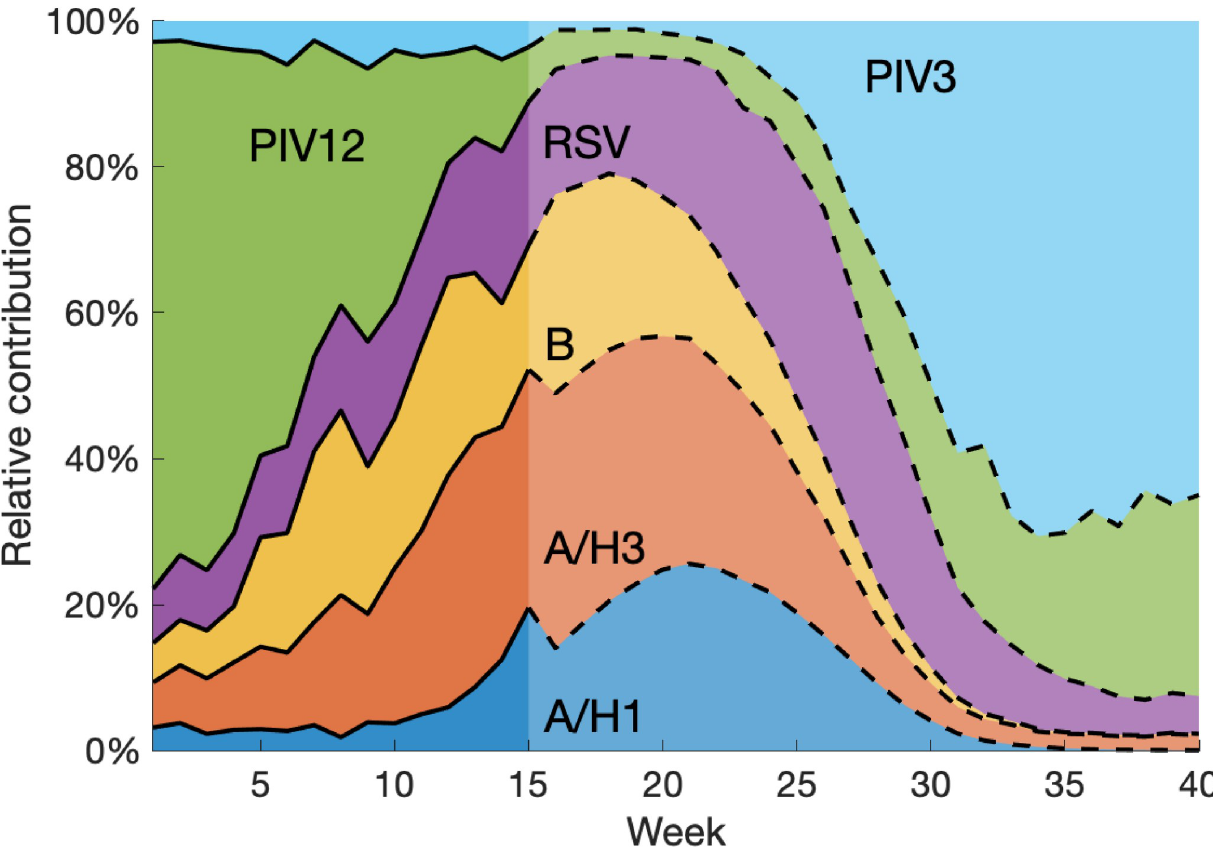
Fig 6. Forecasting the relative contribution of each pathogen to ILI. Forecasts were generated for national data at week 15 during the 2010–2011 season. The relative contribution before week 15 was inferred using available data. After week 15, it is obtained by normalizing the weighted predicted signal of each pathogen. Note that we only considered the relative contribution among the six examined viruses. Contributions from other pathogens were not included.